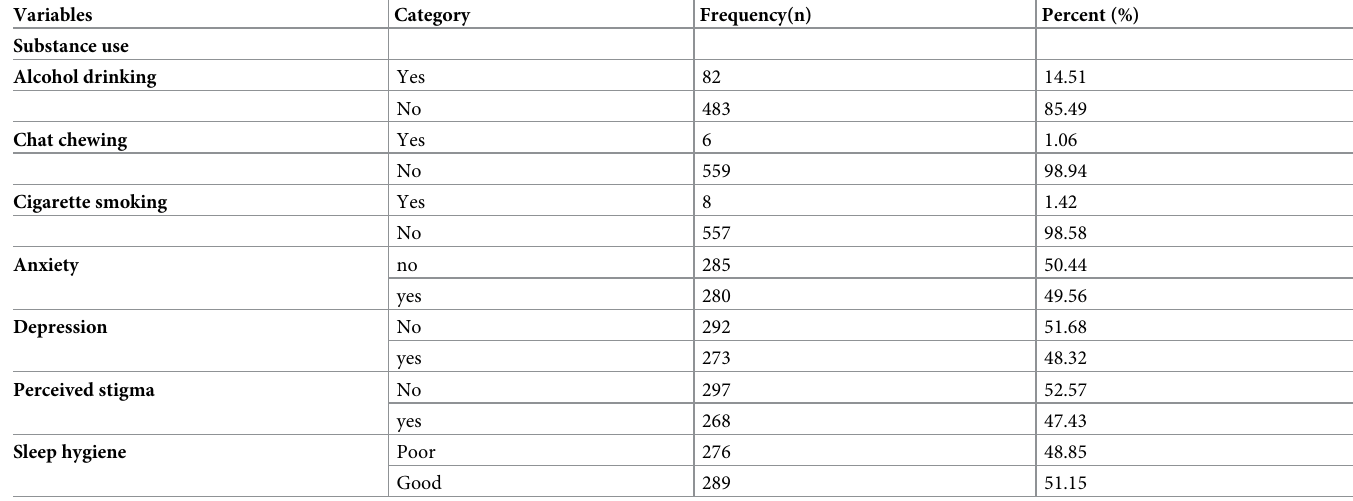
Table 3. Behavioral and psychological characteristics of adult patients with epilepsy attending follow up care at referral hospitals in Amhara region, Ethiopia, 2021 (n = 565).